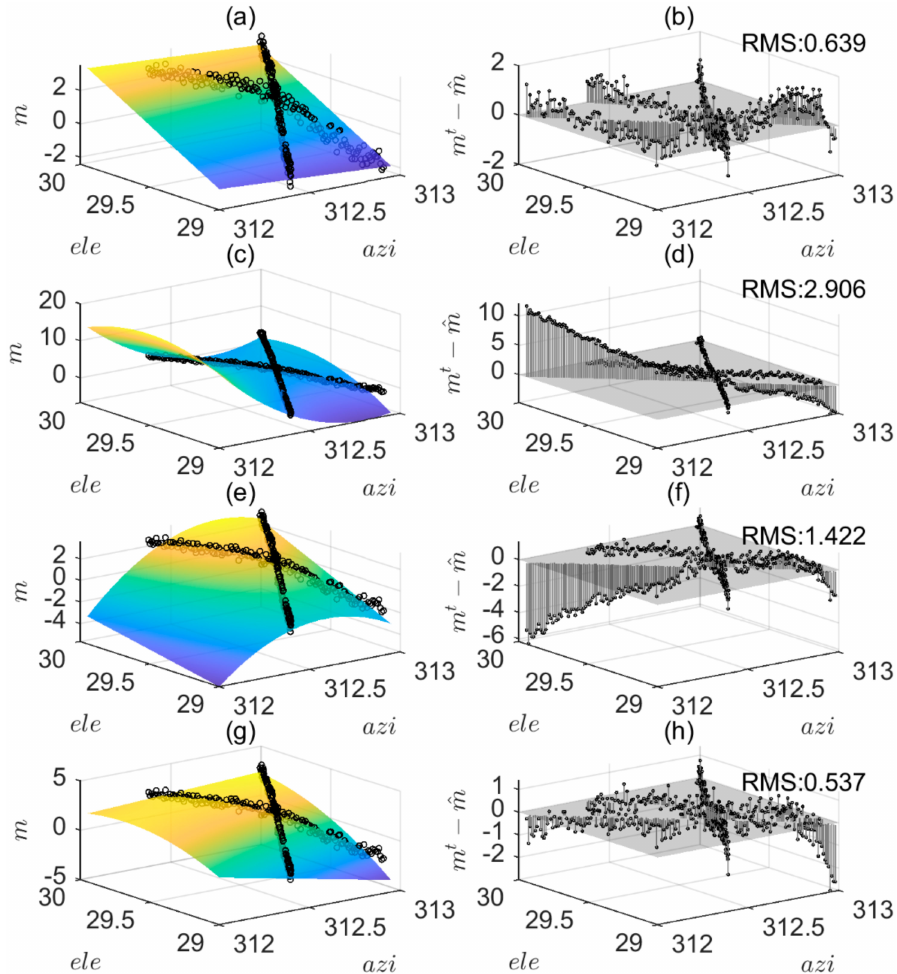
Figure 5. The fitting and application results of four trend surface models constructed from the previous day of grid (30, 313). ( a , b ) The fitting surface and residual plot after multipath correction of the linear trend surface model. ( c , d ) The fitting surface and residual plot after multipath correction of the T-MHM quadratic trend surface model. ( e , f ) The fitting surface and residual plot after multipath correction of the AT-MHM QA trend surface model. ( g , h ) The fitting surface and residual plot after multipath correction of the AT-MHM QE trend surface model. X, Y-axis unit: degree, Z-axis unit: